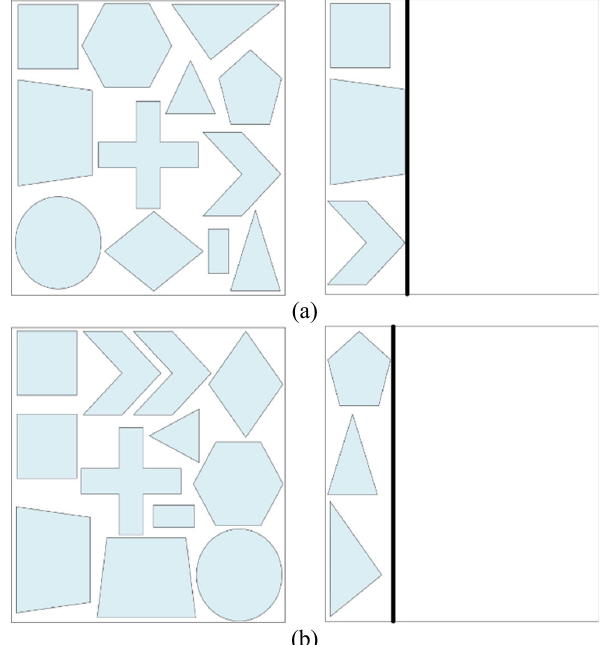
Fig. 1. Diagrammatic drawing of the preferred solution selection